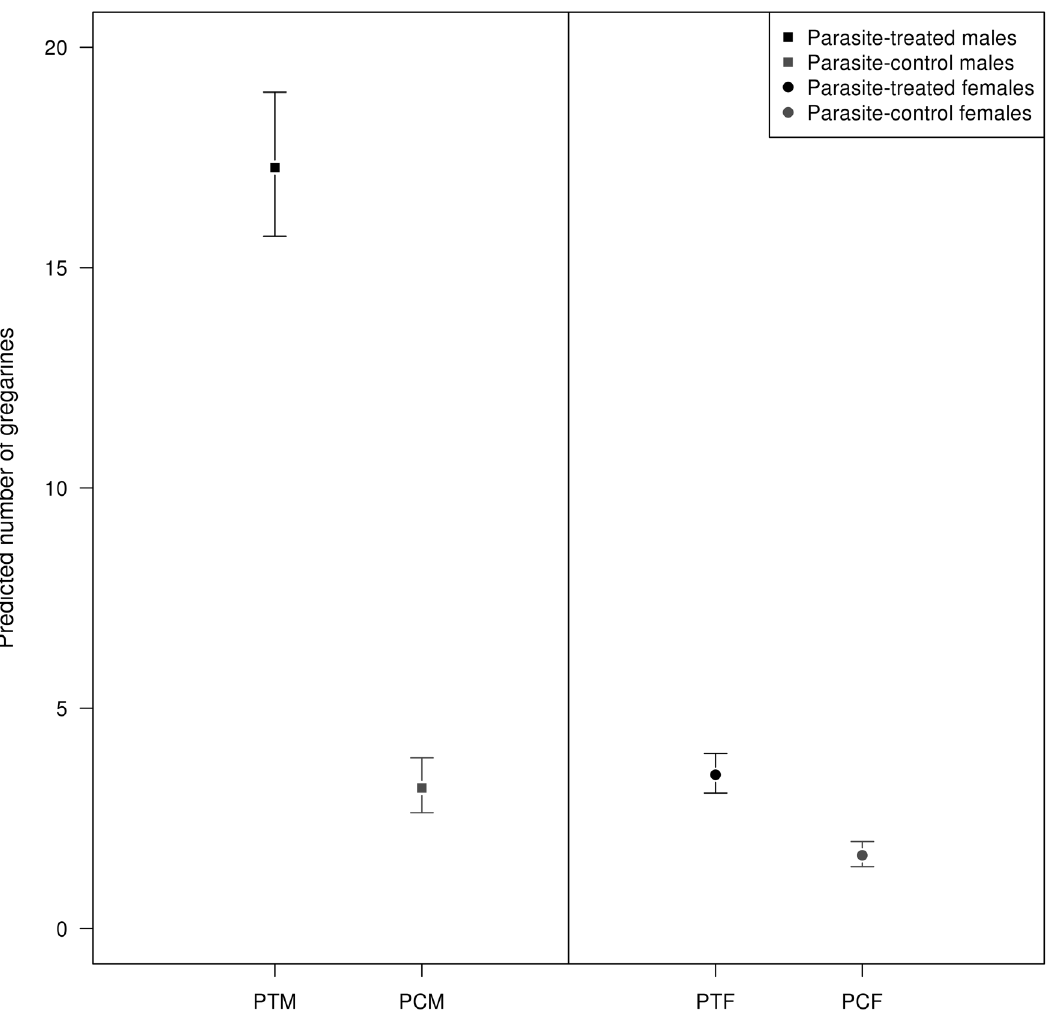
Figure 8. Parasitism rate after experimental infection in both sexes. Predicted abundance of gregarines according to sex and experimental infection interaction. Error bars show 95% confidence